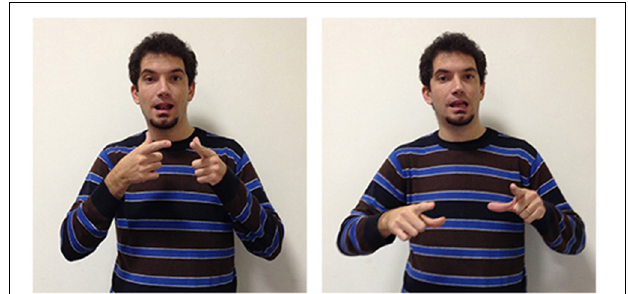
FIGURE 14 | LIS sign LANGUAGE / LINGUA .